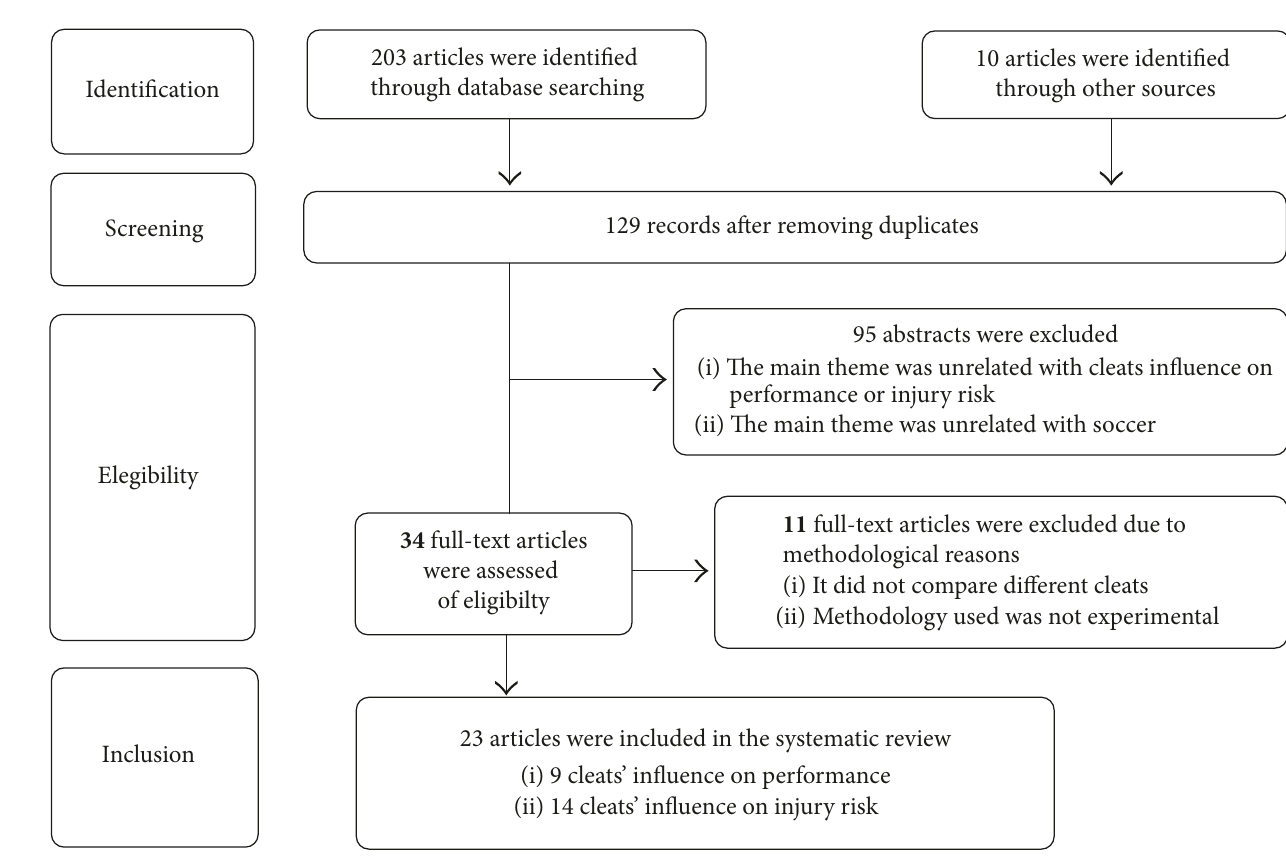
Figure 1: Study selection and inclusion